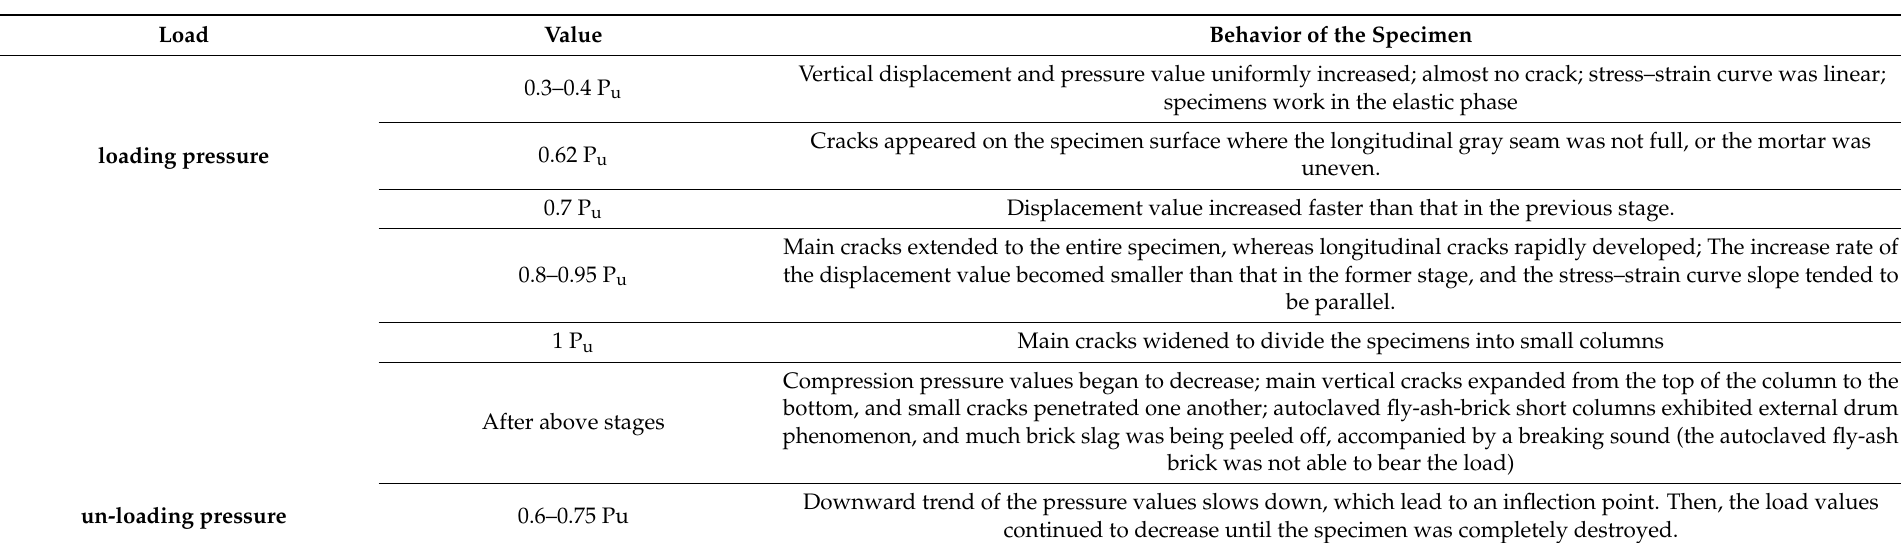
Table 1. Deformation characteristics of the autoclaved fly-ash-brick